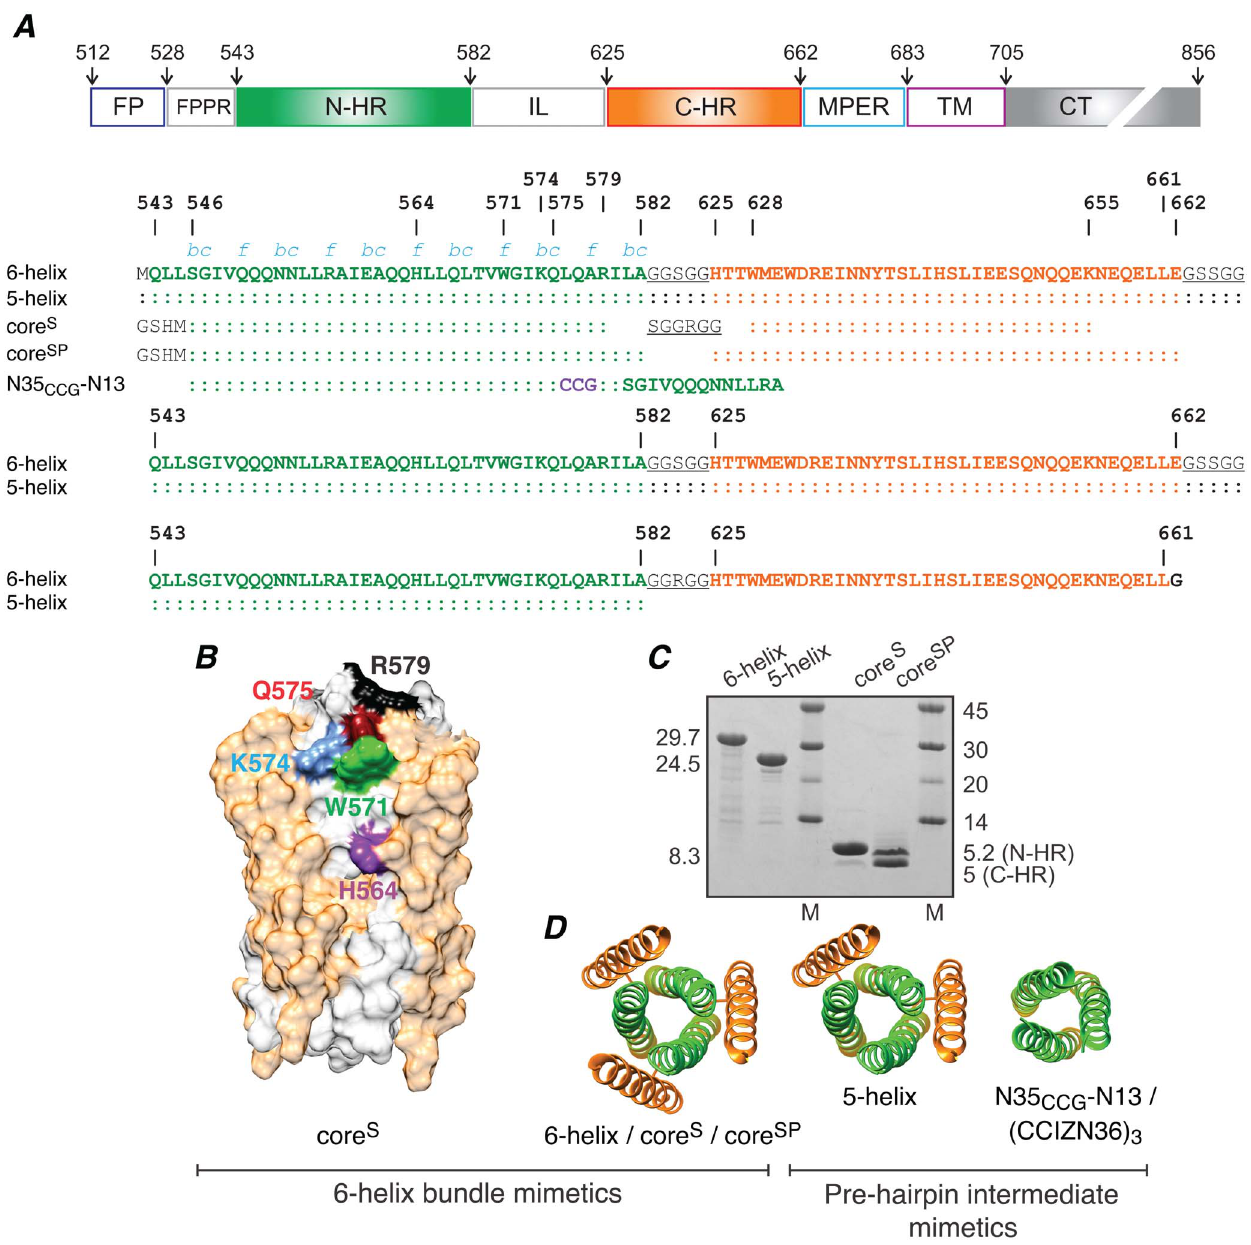
Figure 1. Engineered mimetics of the pre-hairpin intermediate and post-fusion six-helix bundle of HIV-1 gp41. ( A ) Domain organization of HIV-1 gp41 and sequences of the six-helix bundle (6-helix, core S and core SP ) and pre-hairpin (5-helix and N35 CCG -N13) mimetics. (FP, fusion protein; FPPR, fusion peptide proximal region; N-HR, N-heptad repeat; IL, immune-dominant linker; C-HR, C-heptad repeat; MPER, membrane proximal external region; TM, transmembrane region; CT, intraviral C-terminal domain.) Three N35 CCG -N13 chains are linked covalently via intermolecular disulfide bridges (CCG, shown in purple) to form a stable helical trimer [19]. N-HR, C-HR and linker residues are shown in green, orange and black (underlined), respectively. Numbering of N-HR and C-HR regions is according to their location in Env from HIV-1 (strain HXB2). Positions in the helical wheel (blue italic) of N-HR residues that are solvent accessible in the six-helix bundle conformation are indicated. ( B ) Interactions of Fab8066 with N-HR residues in thecontext of thesix-helix bundle construct core S mappedby Alascanning mutagenesis andimmunoblotting[22]. The core S trimer is shown as a surface representation with N-HR and C-HR regions of gp41 in white and light orange, respectively. N-HR surface accessible residues (H564, W571, K574 and Q575) identified as sites of interaction with Fab8066 are shown in distinct colors. ( C ) Relative migration on SDS-PAGE of the gp41 mimetics used in this study. Molecular weights of constructs and markers (M) are indicated in kDa. N-HR and C-HR denote peptides which assemble to form the six-helix bundle conformation of core SP . ( D ) Ribbon representations of the gp41 constructs. 5-helix, CCIZN36 and N35 CCG -N13 are pre-hairpin intermediate mimetics with one or more exposed N-HR helices, that are otherwise partially shielded in the six-helix bundle. The three N-HR peptide chains in N35 CCG -N13 and CCIZN36 are stabilized as disulfide-linked trimers by fusion with either a 13-residue repeat of the N-HR [19] or an N-terminal isoleucine zipper segment [37], respectively. 6-helix and 5-helix are single chain polypeptides with the N-HR (N) and C-HR (C) regions connected by a six- residue linker in the order N-C-N-C-N-C and N-C-N-C-N, respectively [18]. Core S and core SP also form a six-helix bundle but as a trimer consisting of 3 hairpin (N-linker-C) peptides and a hexamer consisting of 3 N-HR and 3 C-HR peptides, respectively (see panel A).